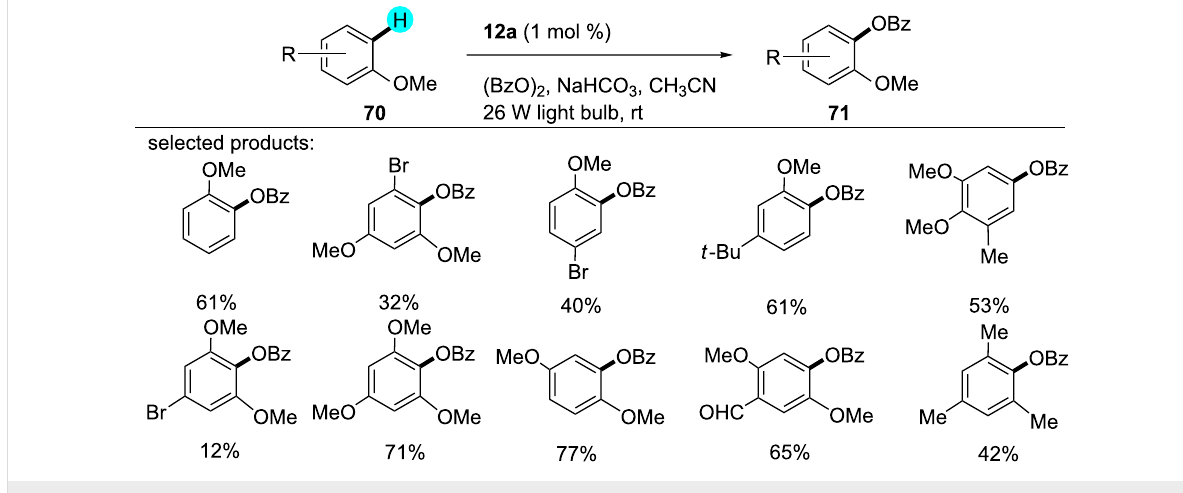
Scheme 9: Monobenzoyloxylation without chelation assistance.